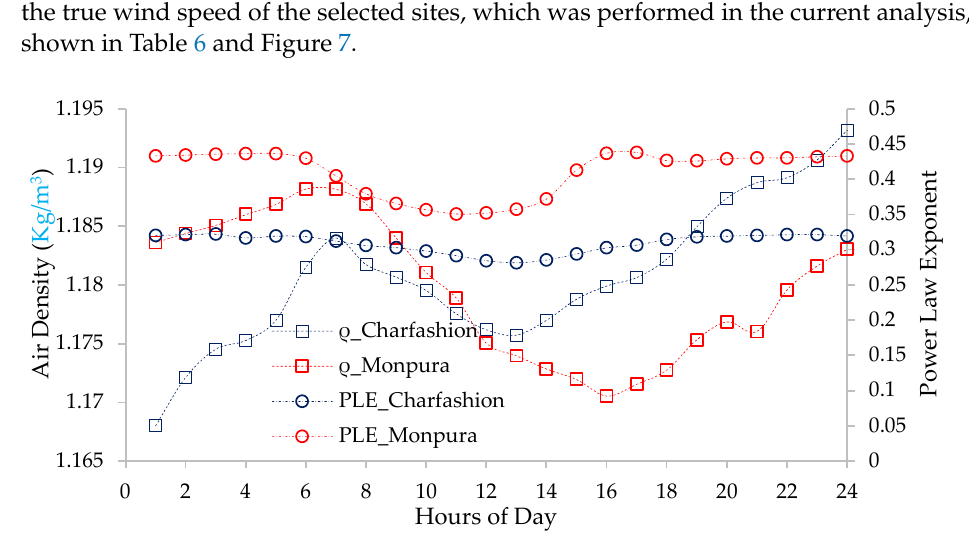
Figure 7. The diurnal variation of the power law exponent (PLE) and the air density of the Charfash- ion and Monpura microsites.